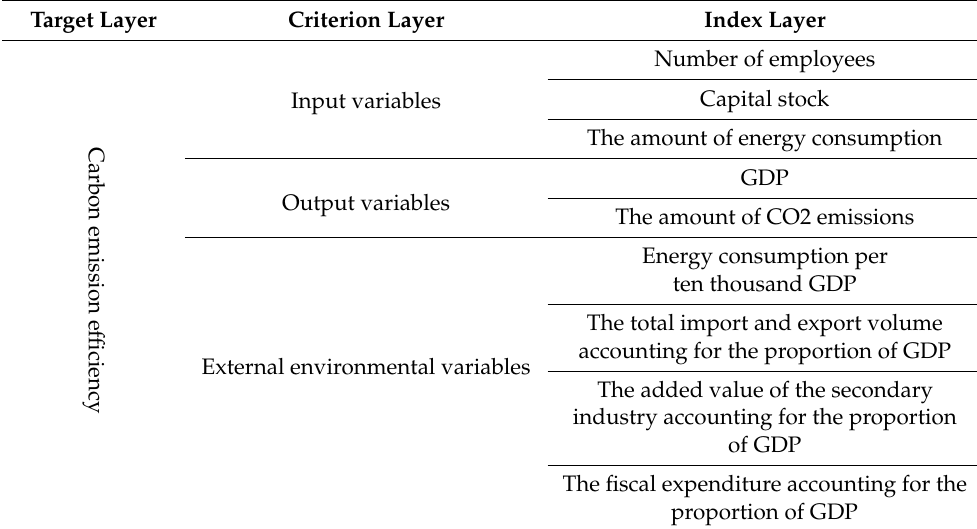
Table 1. The measurement index system of carbon emission